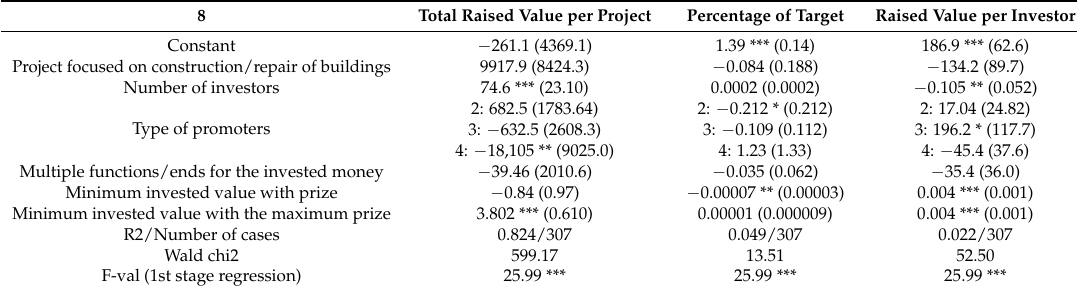
Table 4. Type of Project: Social/Causes. Estimations for total funded value, percentage of target, and value per investor